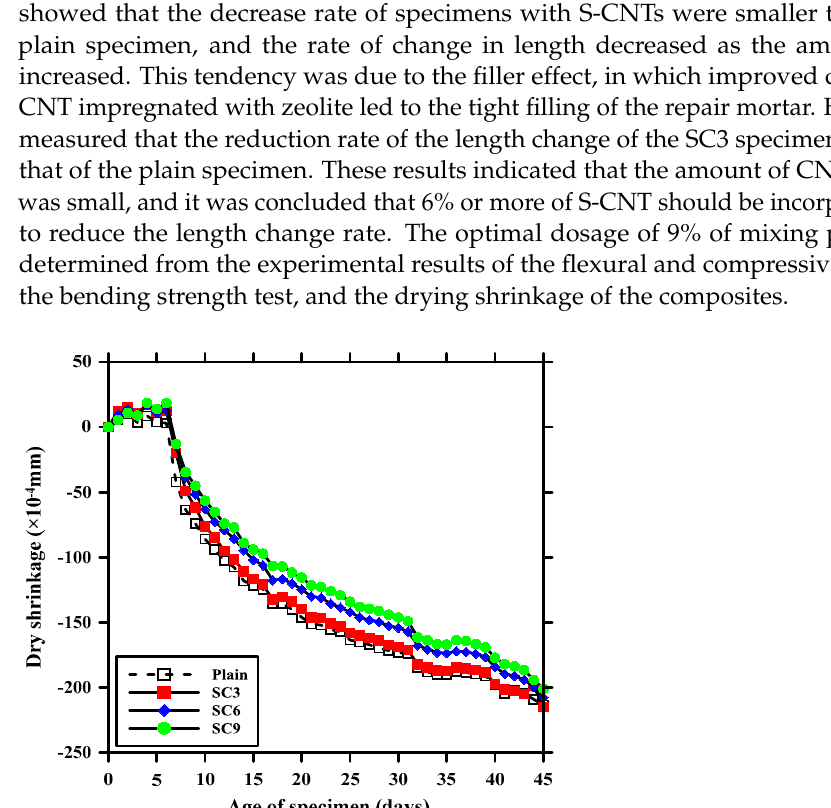
Figure 10. Pore size distribution of cementitious composites with CNT and S-CNT.